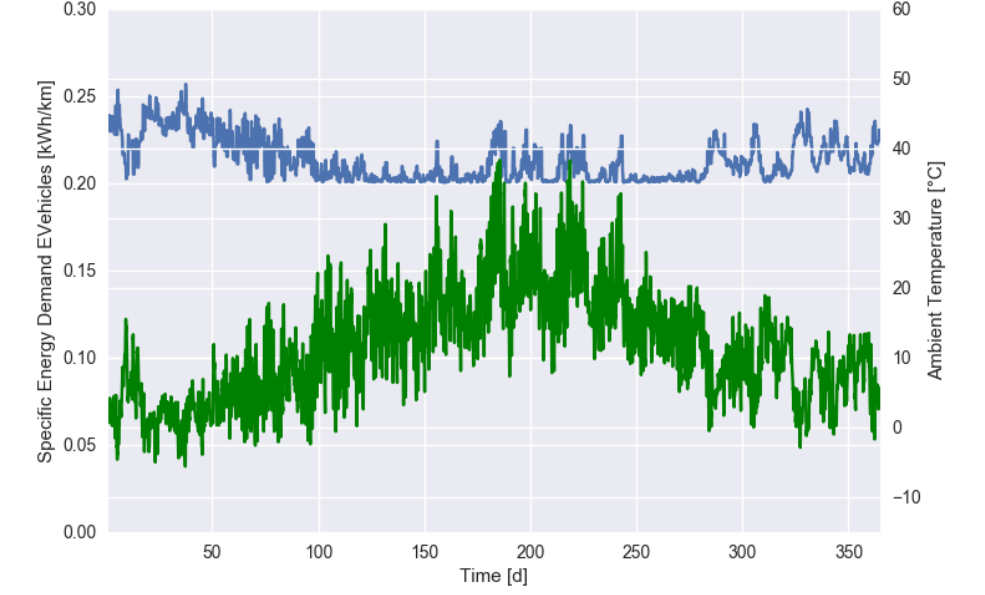
Figure 3. Temperature-dependent energy demand (in kWh/km) of